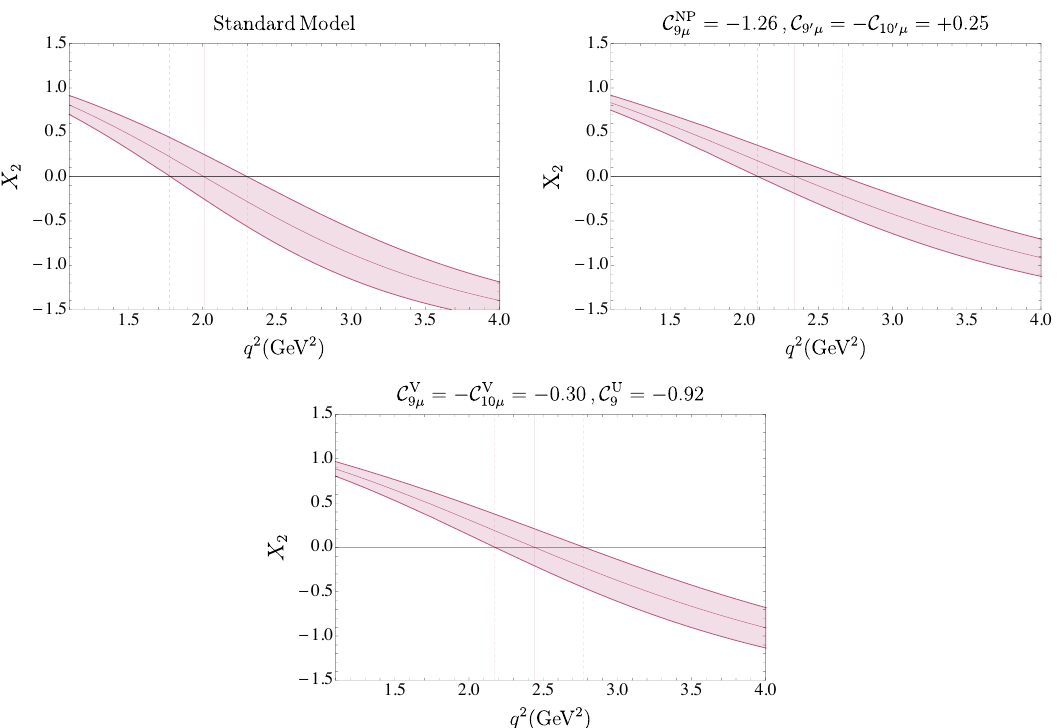
Figure 7 . X 2 predictions for the SM, Hypothesis V and Scenario 8, including theory uncertainties.